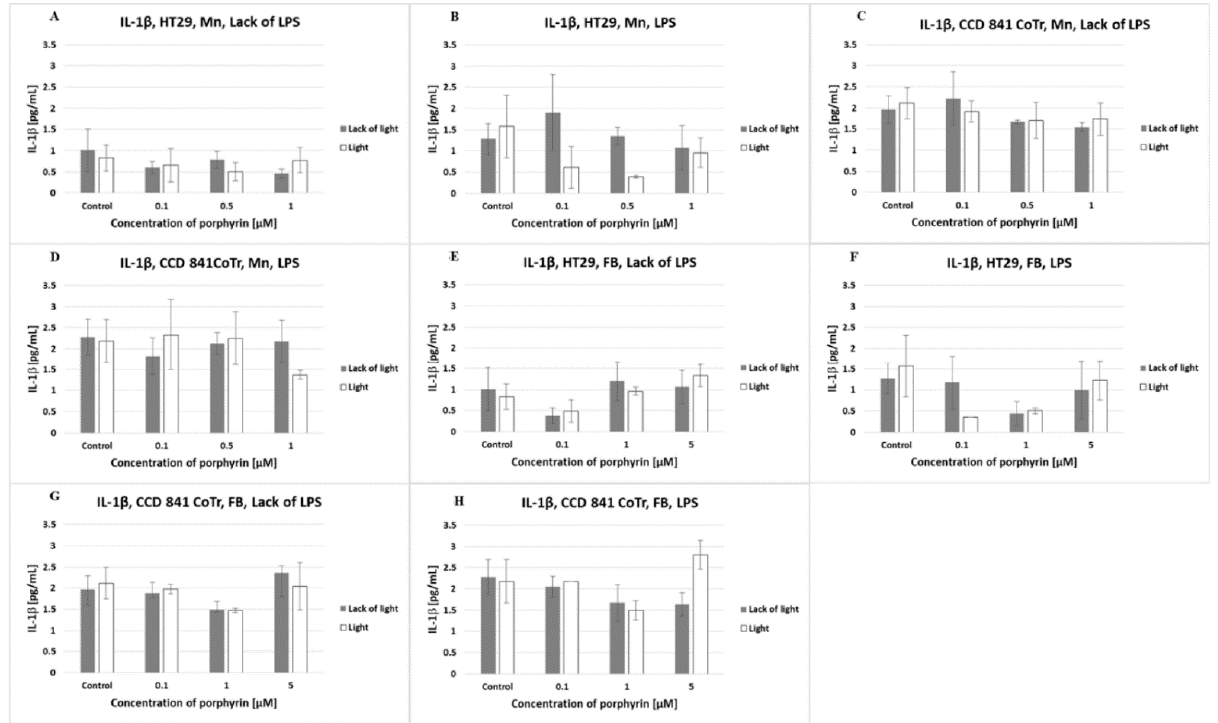
Figure 6 . IL-1 β secretion at the HT29 cell line (A, B, E, F) and culture of CCD 841 CoTr cells (C, D, G, H) over 24 h of Figure 6. IL-1 β secretion at the HT29 cell line ( A , B , E , F ) and culture of CCD 841 CoTr cells ( C , D , G , H ) incubation with manganese (Mn) (A-D) and free-base (FB) (E-H) porphyrins. ELISA test. Cells treated with porphyrin over 24 h of incubation with manganese (Mn) ( A – D ) and free-base (FB) ( E – H ) porphyrins. ELISA compared with a non-treated control culture. Cells treated with porphyrin compared with cells treated with porphyrin test. Cells treated with porphyrin compared with a non-treated control culture. Cells treated with after pre-incubation with LPS. Columns and bars show the mean ± standard deviation ( n = 3). * - Statistical significance porphyrin compared with cells treated with porphyrin after pre-incubation with LPS. Columns and was analyzed at p < 0.05. bars show the mean ± standard deviation ( n =